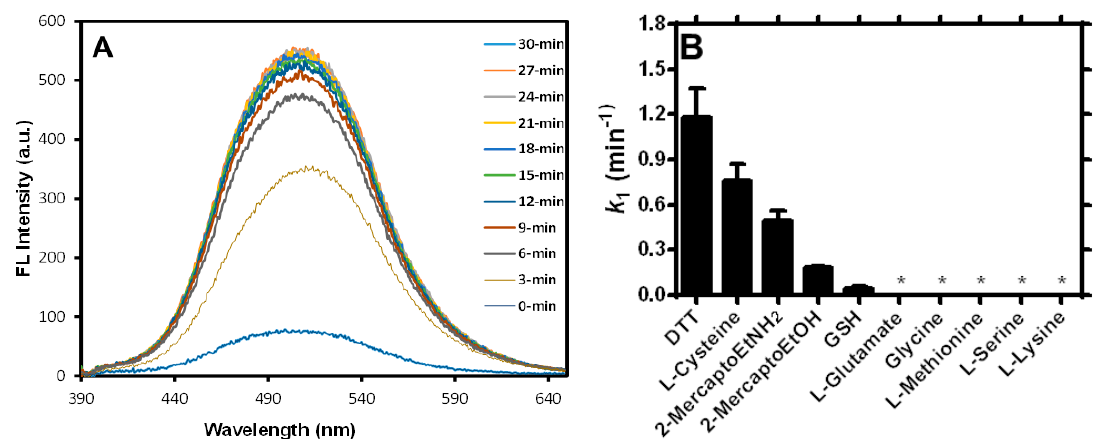
Figure 1. Release of EDANS fluorescence by 11 when reacting with thiol-containing compounds. ( A ) The time-dependent increase in EDANS fluorescence (FL intensity) in a reaction of 11 (25 μ M) with DTT (50 mM). ( B ) Differential reactivity of 11 toward reactants as demonstrated by the pseudo-first-order rate constants k 1 of the reactions. Please see Materials and Methods for the details. Each reactant was analyzed four times in order to acquire the averaged k 1 values and standard deviation (the error bar). The symbol * indicates that 11 had no detectable reactivity so that values of averaged k 1 and standard deviation could not be determined; 2-MercaptoEtNH 2 , 2-aminoethanethiol; 2-MercaptoEtOH, 2-mercaptoethanol.